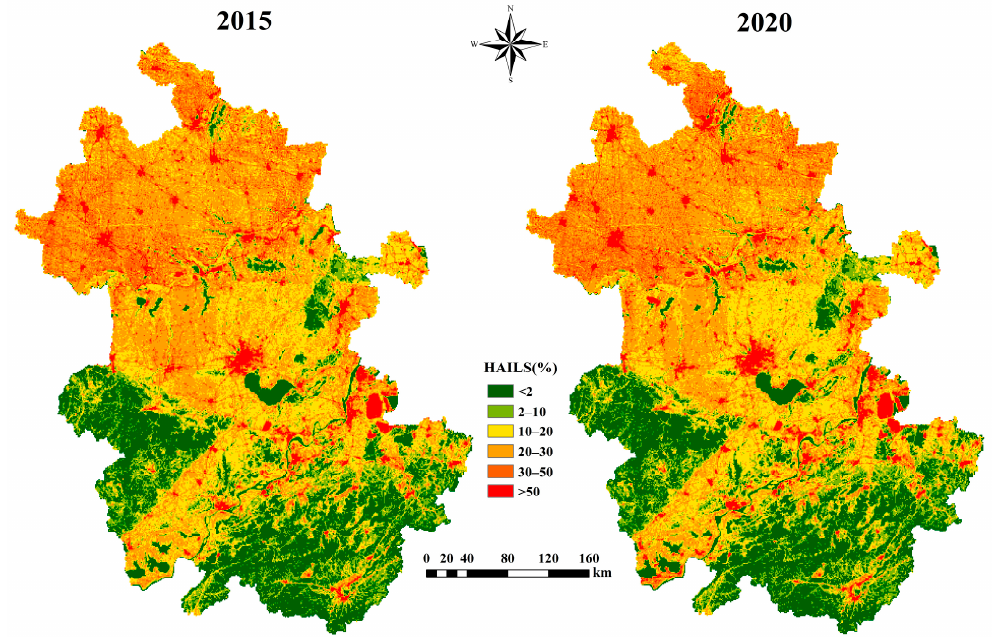
Figure 2. Spatial distribution of HAILS in 2015 ( left ) and 2020 ( right ) of Anhui Province. From 2015 to 2020, the mean HAILS in Anhui Province increased slightly by 0.4%, Table 2. Grading analysis of HAILS data from 2015 to